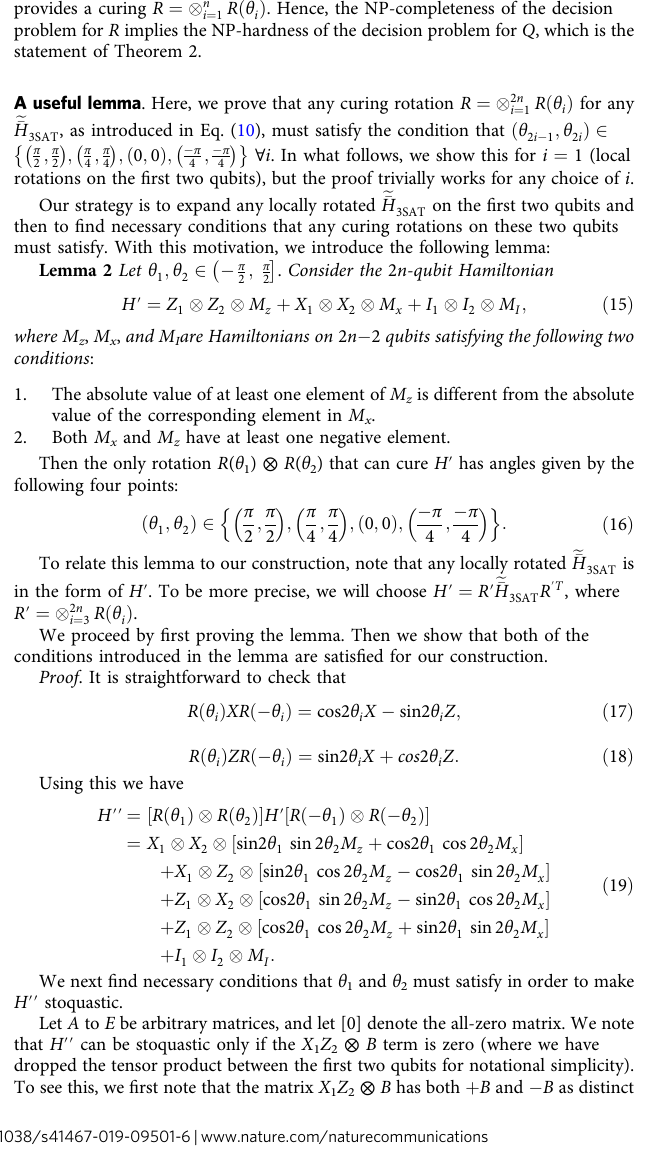
Fig. 3 Reducing the continuous region of solutions to a discrete set. The set of possible orthogonal transformations that can cure Eq. (10)) reduces to a discrete set. We assign the value of each binary variable satisfying a 3SAT instance depending on the value of the curing transformation. We set x i = 0 if the curing transformation